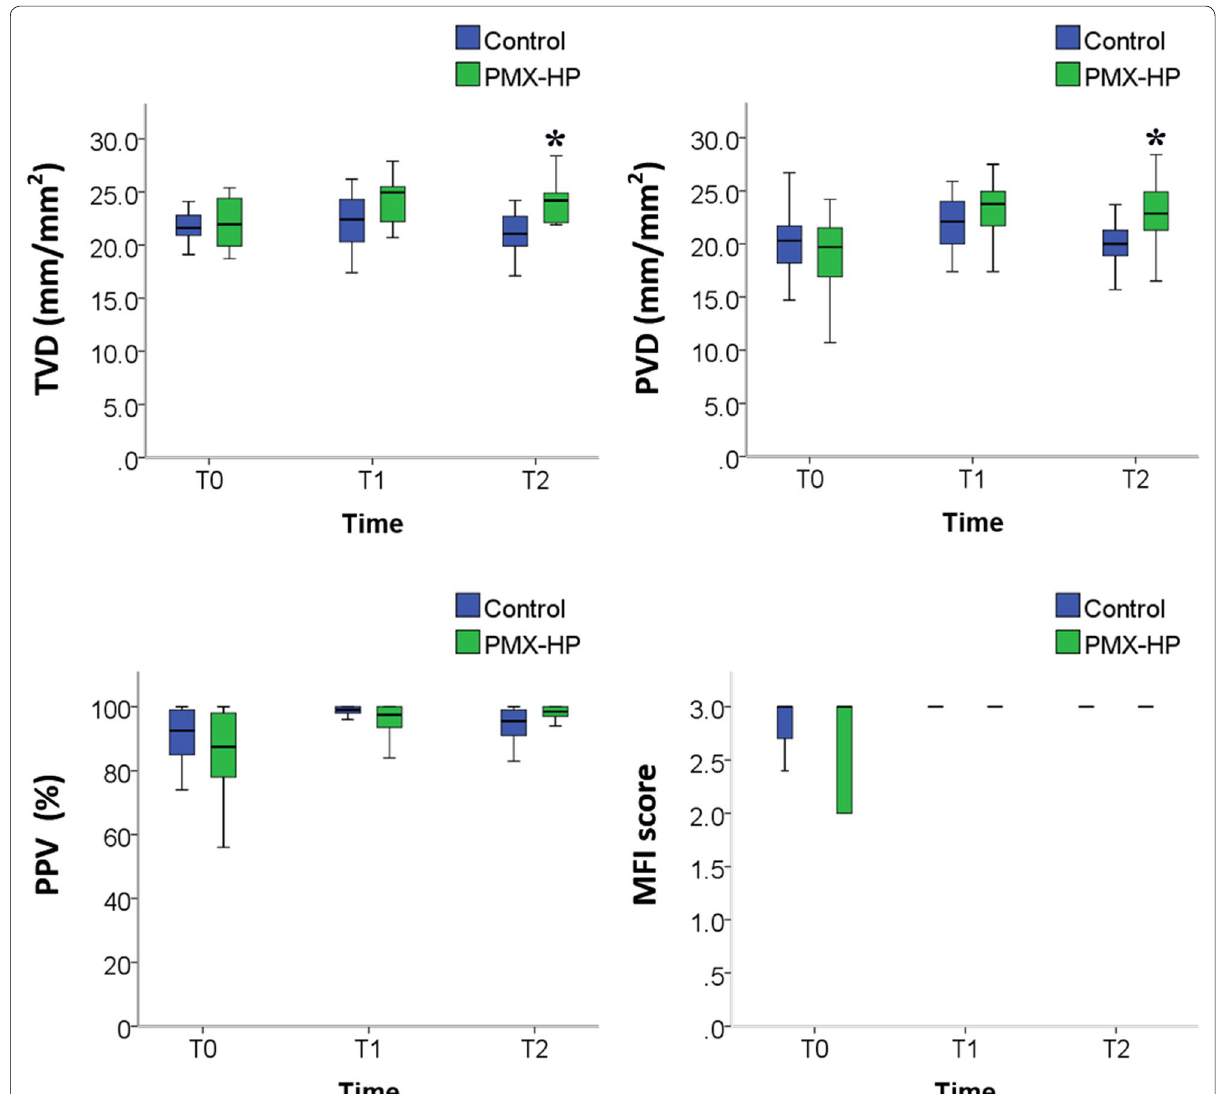
Fig. 3 Comparison of microcirculation parameters between the control and PMX‑HP groups. n enrollment; T1, at 24–26 h after enrollment; and T2, 48 h after enrollment. MFI microvascular flow index, PMX ‑ HP polymyxin B hemoperfusion, PPV proportion of perfused vessels, PVD perfused vessel density, TVD total vessel density. * p < 0.05 by intent‑to‑treat analysis using Mann–Whitney